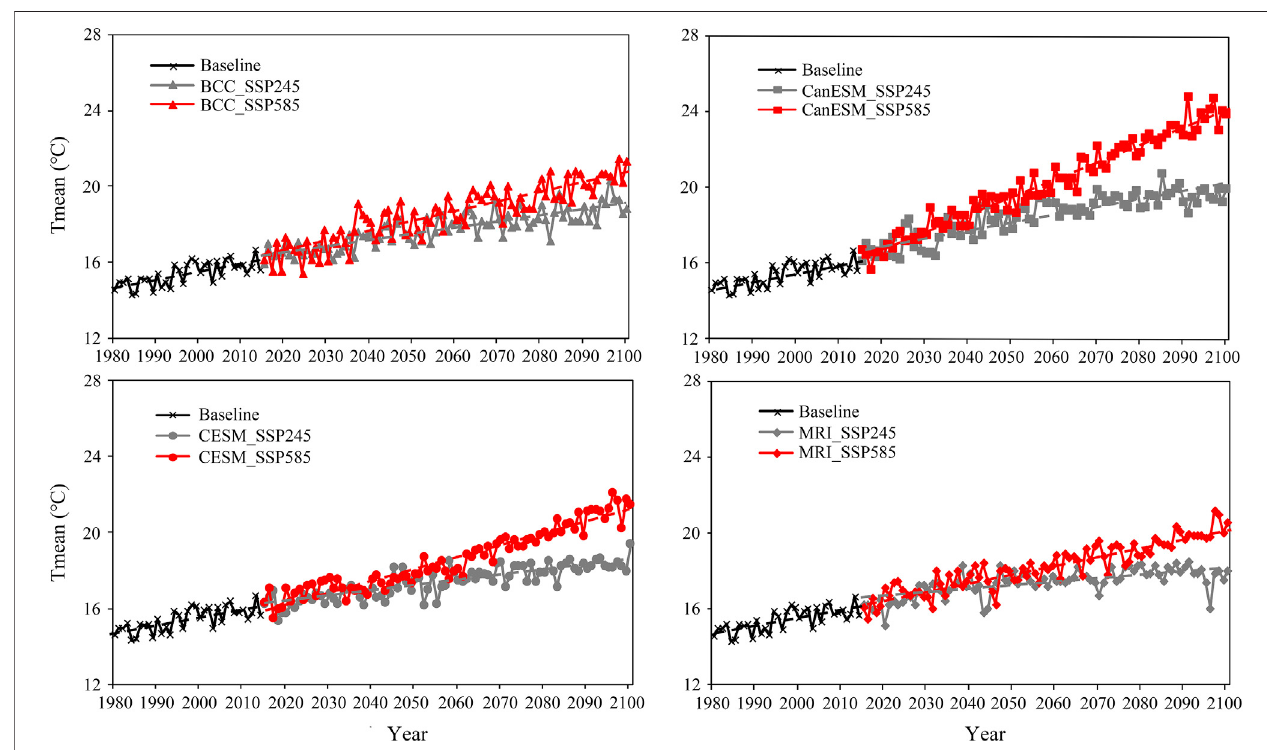
FIGURE 5 | Trend results of annual average air temperature for each GCM in the Xixian basin from 1980 to 2100.